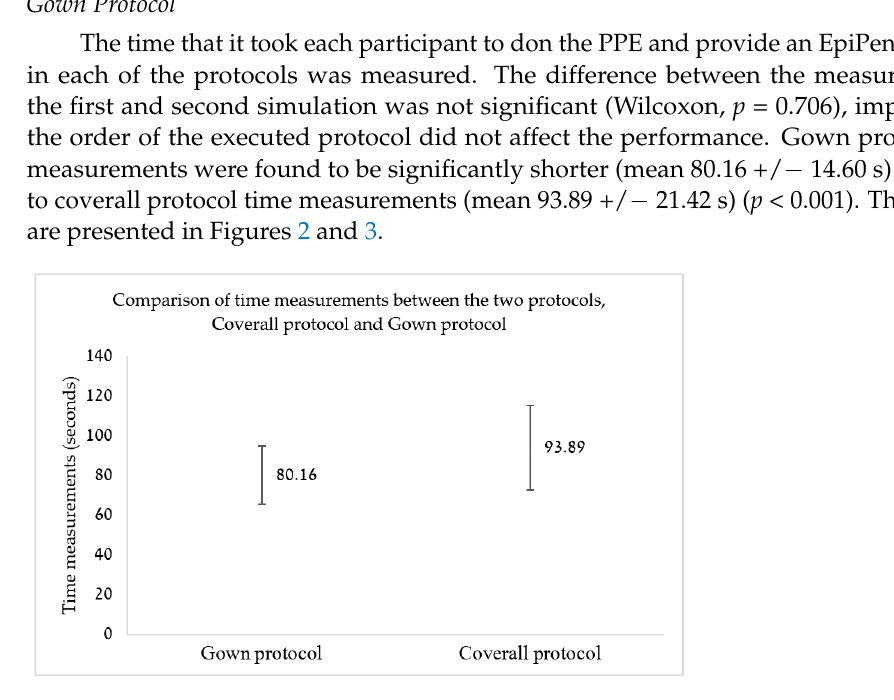
Figure 3. Comparison of time measurements of each participant between the two protocols exam- ined in the study: coverall protocol and gown protocol. The solid line represents the equality line, and the dotted line is the trendline of the measurements.